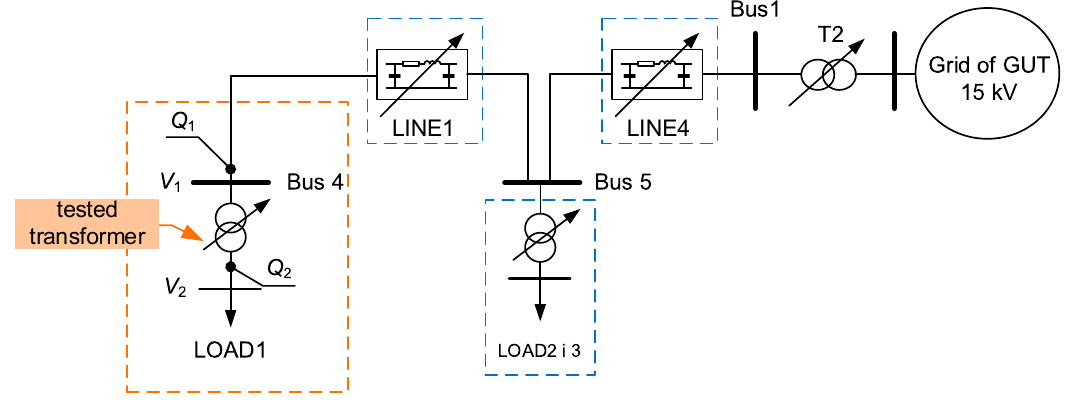
Figure 14. Simplified network diagram used in laboratory tests.